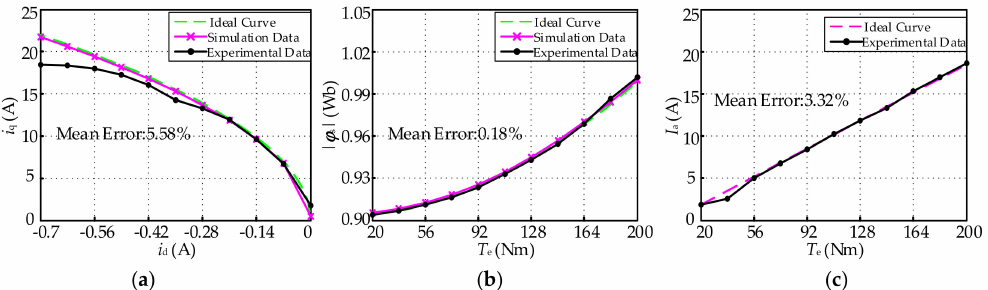
Figure 11. The performance of proposed on-line maximum torque per ampere (MTPA) method. ( a ) i d – i q plot; ( b ) T e − | s | plot; ( c ) T e – I A